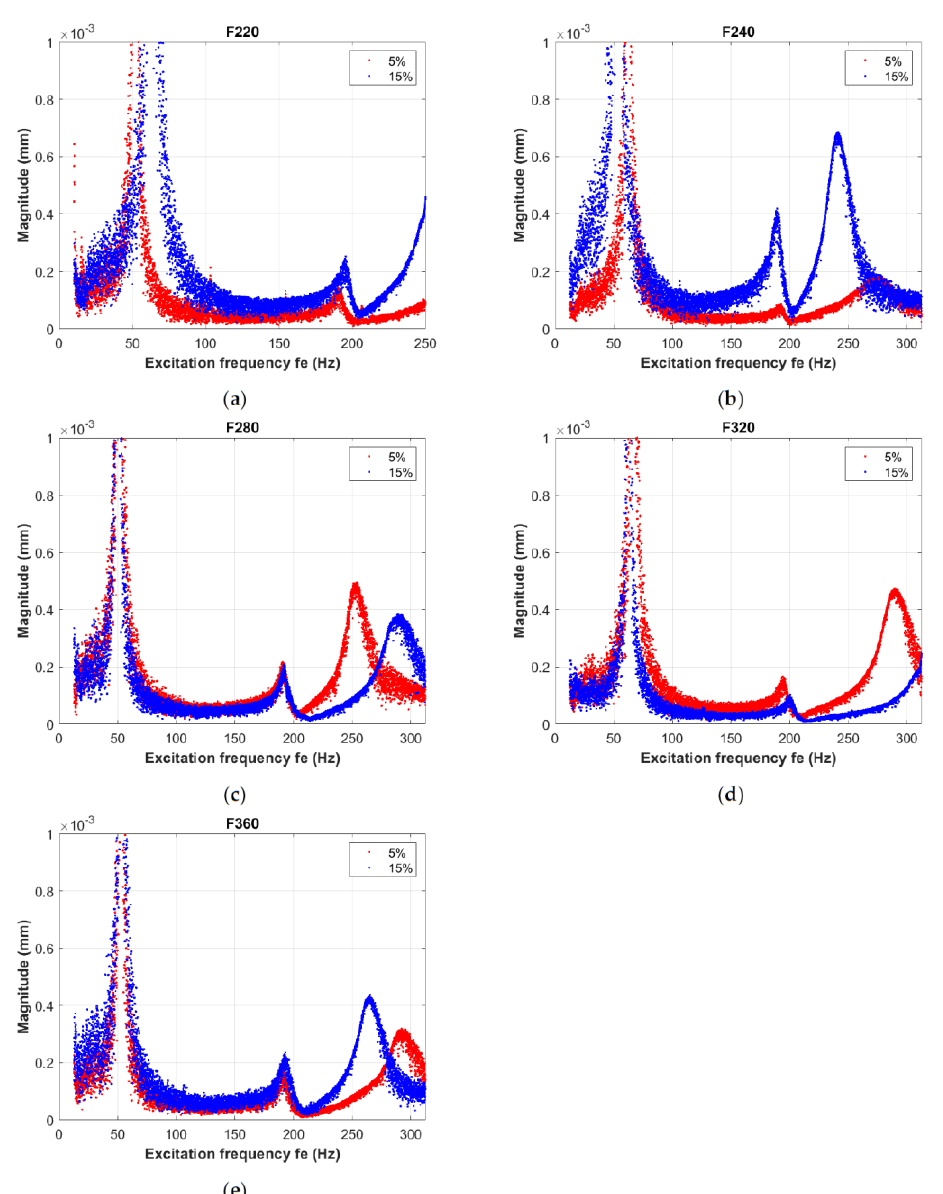
Figure 2. The amplitude – frequency responses of the beams measured by vibrometer scanning head PSV-500 for 5% and 15% concentrations of modifier in the cases of samples with coarse-grained alumina F220 ( a ), F240 ( b ), F280 ( c ), F320 ( d ), and ( e ) F360,